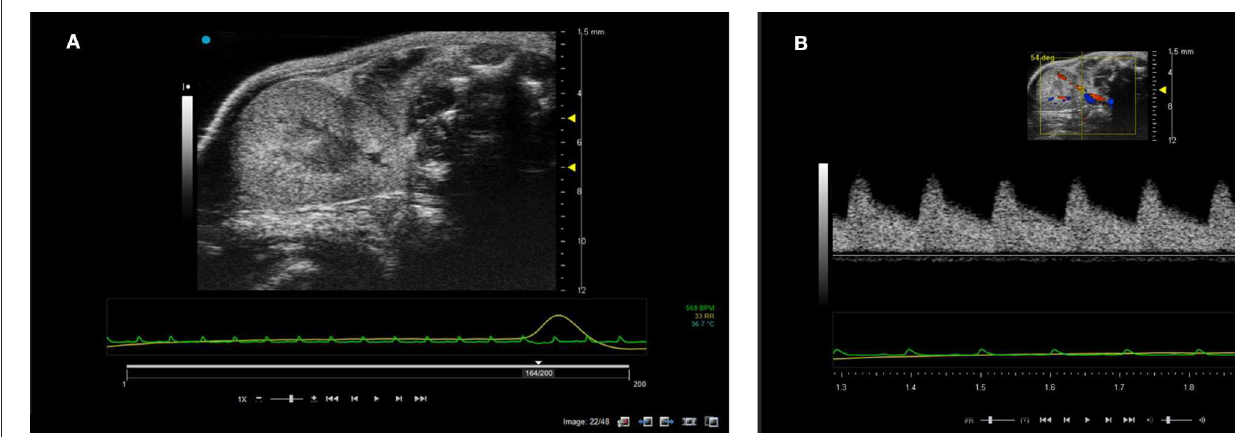
FIGURE 14 | (A) B-mode image of kidney. Note the two focal positions on the image. (B) Duplex image of mouse kidney. In the Duplex image, the sample volume is localized using the color Doppler box as an indicator to show where the vessel lies and direction of blood flow.